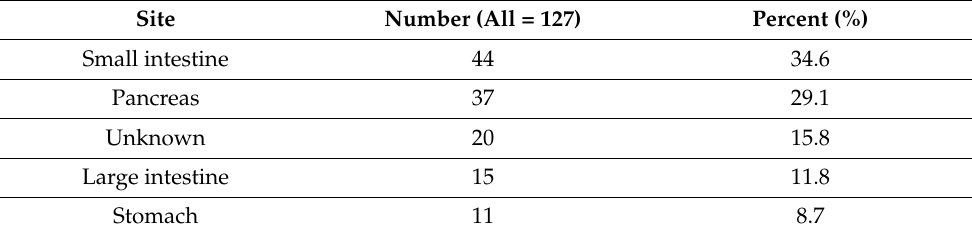
Table 4. Distribution of primary tumor locations in the group of 127 patients analyzed in the main part of the study.